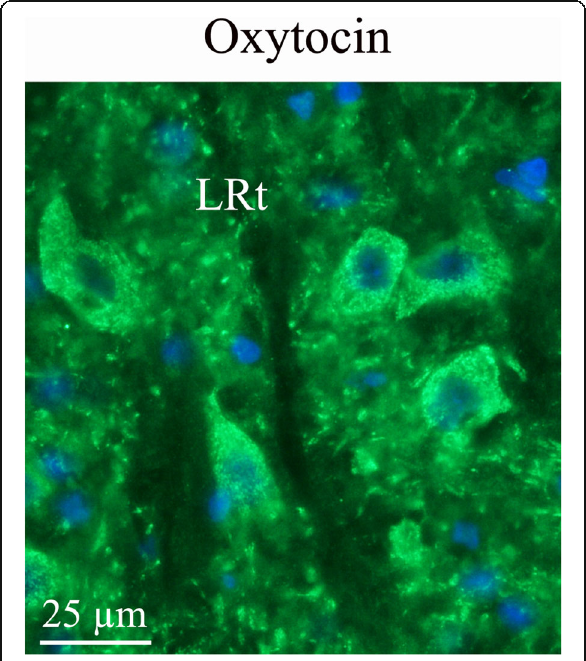
Fig. 8 Oxytocin immunohistochemistry in the lateral reticular nucleus. In the reticular formation, a few bodies of the lateral reticular nucleus (LRt) were found to express